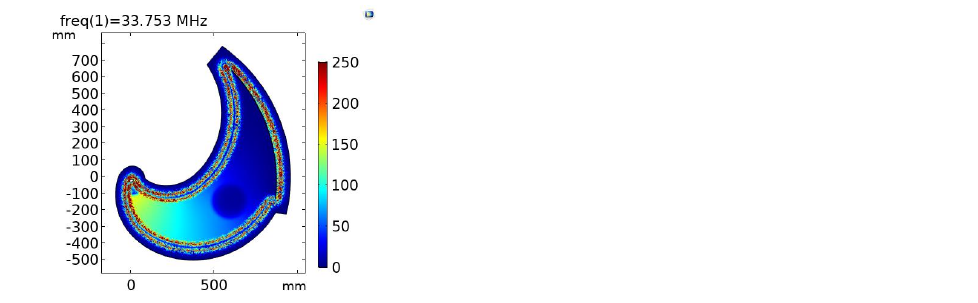
Figure 10. Magnitude of the electric field component E ⊥ orthogonal to the median plane.